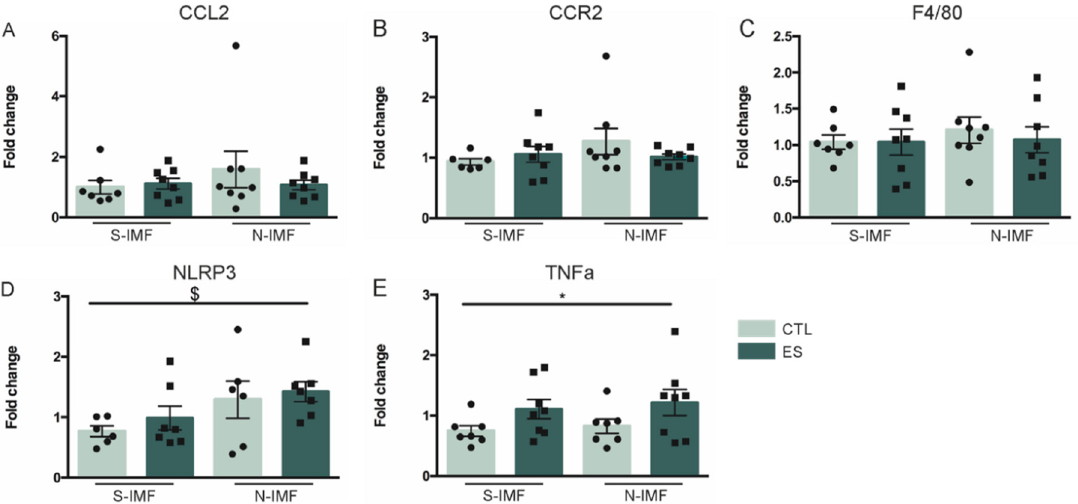
Figure 4. Effects of ES and postnatal diet on adipose tissue inflammatory gene expression at P42. ( A – C ) ES and postnatal diet do not affect CCL2, CCR2 and F4/80 expression. ( D ) N-IMF increased NLRP3 expression at P42. ( E ) ES increases TNF α expression levels. Data are presented as mean ± SEM; * condition effect; $ diet effect; p < 0.05.